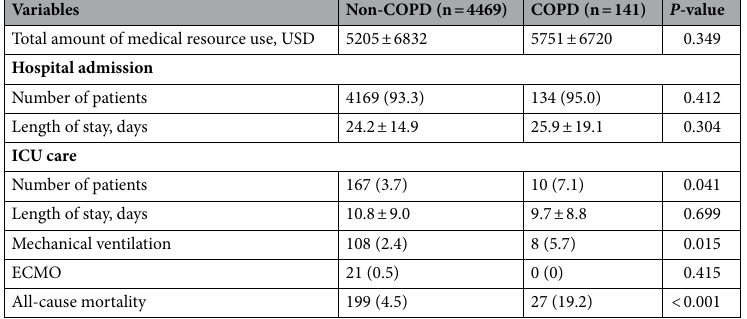
Variables Non-COPD (n = 4469) COPD (n = 141) P